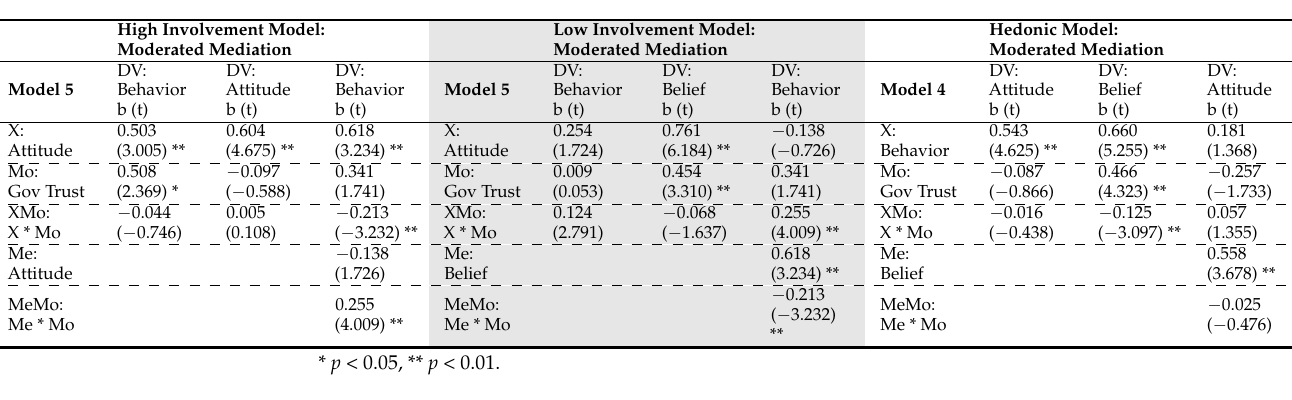
Table 5. Government Trust Model in Korea.